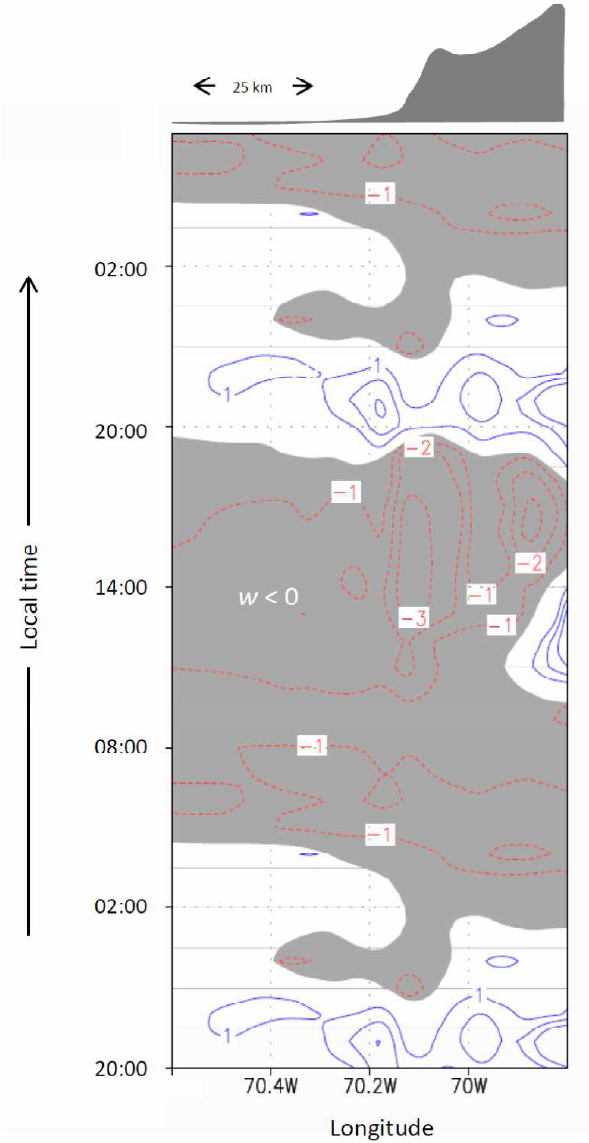
Fig. 9. Time–longitude cross section of WRF-simulated vertical velocity ( W , cms − 1 ) at 800hPa averaged between 19–22 ◦ S and over the 4-day run. Positive values (upward motion) in blue, solid contours; negative values in red, dashed contours. Light shading indicates subsidence. For display purposes, part of the mean diurnal cycle is repeated. The dark gray area at top represents the average topographic profile.